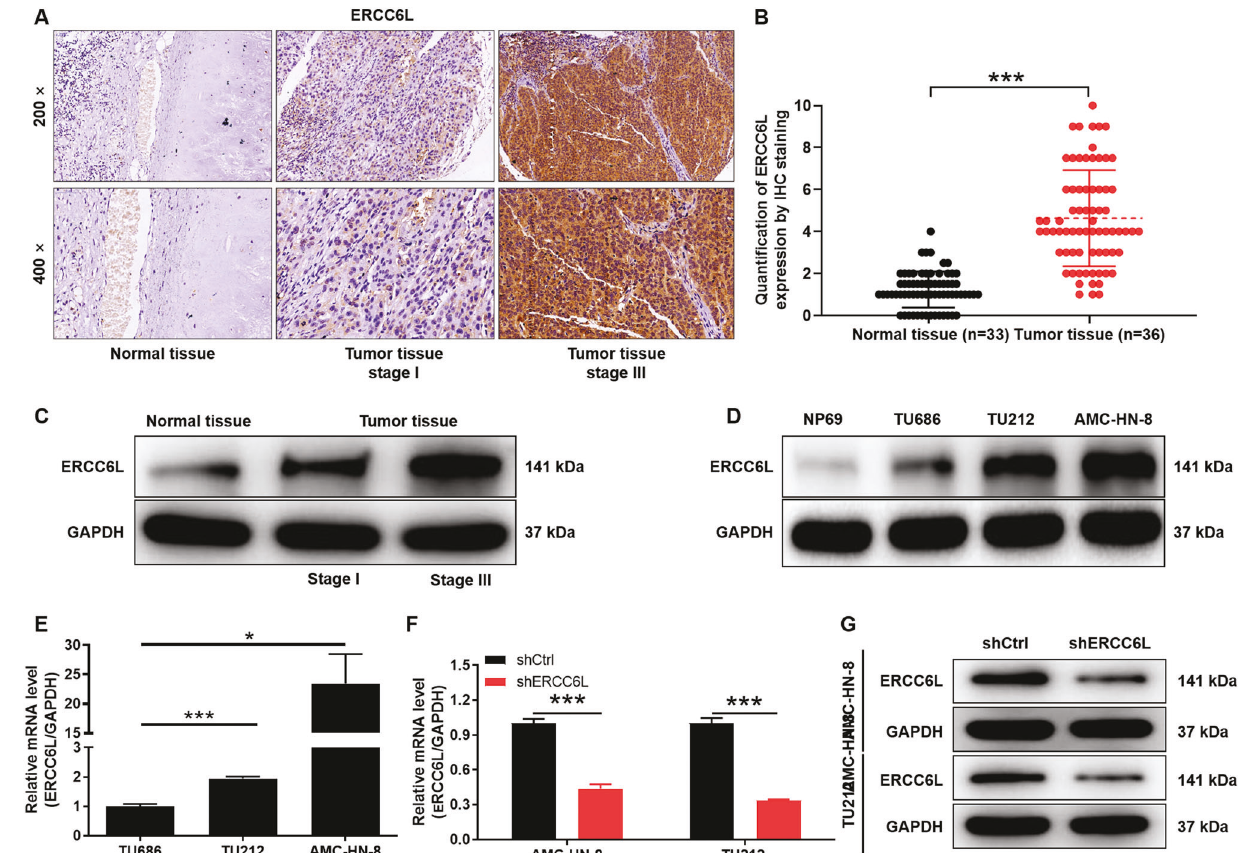
Fig. 1 Expression detection of ERCC6L in LSCC. A Representative IHC staining of ERCC6L expression in LSCC tissues and normal tissues. B Quantitative IHC results of ERCC6L expression in LSCC tissue ( n = 36) and adjacent normal tissue ( n = 33). C The mRNA expression of ERCC6L in LSCC cells such as TU686, TU212, and AMC ‐ HN ‐ 8 was detected using qPCR. D The mRNA expression of ERCC6L was detected after shRNA targeting ERCC6L (shERCC6L) was transduced into AMC-HN-8 and TU212 cells. E The protein levels of ERCC6L in shERCC6L-mediated AMC-HN- 8 and TU212 cells was analyzed by western blotting. F The mRNA expression of ERCC6L was detected after shRNA targeting ERCC6L (shERCC6L) was transduced into AMC-HN-8 and TU212 cells. G The protein expression of ERCC6L was detected after shERCC6L was transduced into AMC-HN-8 and TU212 cells. The representative images were selected from at least three independent experiments. Data was shown as mean ± SD. * P < 0.05, *** P < 0.001. (Fig. 1D, E). The above results revealed that ERCC6L was generally highly expressed in LSCC. Next, the correlation between ERCC6L expression and clinicopathological features of LSCC patients was preliminarily analyzed using Mann-Whitney U. Of note, patholo- gical staging criteria for LSCC patients were based on the seventh edition of the American Joint Committee on Cancer (AJCC) Cancer Staging Manual. Our data indicated that the expression level of ERCC6L was signi fi cantly positively correlated with T in fi ltrate and TNM of LSCC ( P < 0.001, Table 2). Consistently, the analysis results of Spearman correlation coef fi cient further con fi rmed the above data ( P < 0.001, Table 3). Taken together, the expression of ERCC6L was elevated in LSCC and correlated with poor prognostic factors, suggesting that ERCC6L may be a diagnostic marker for this disease.